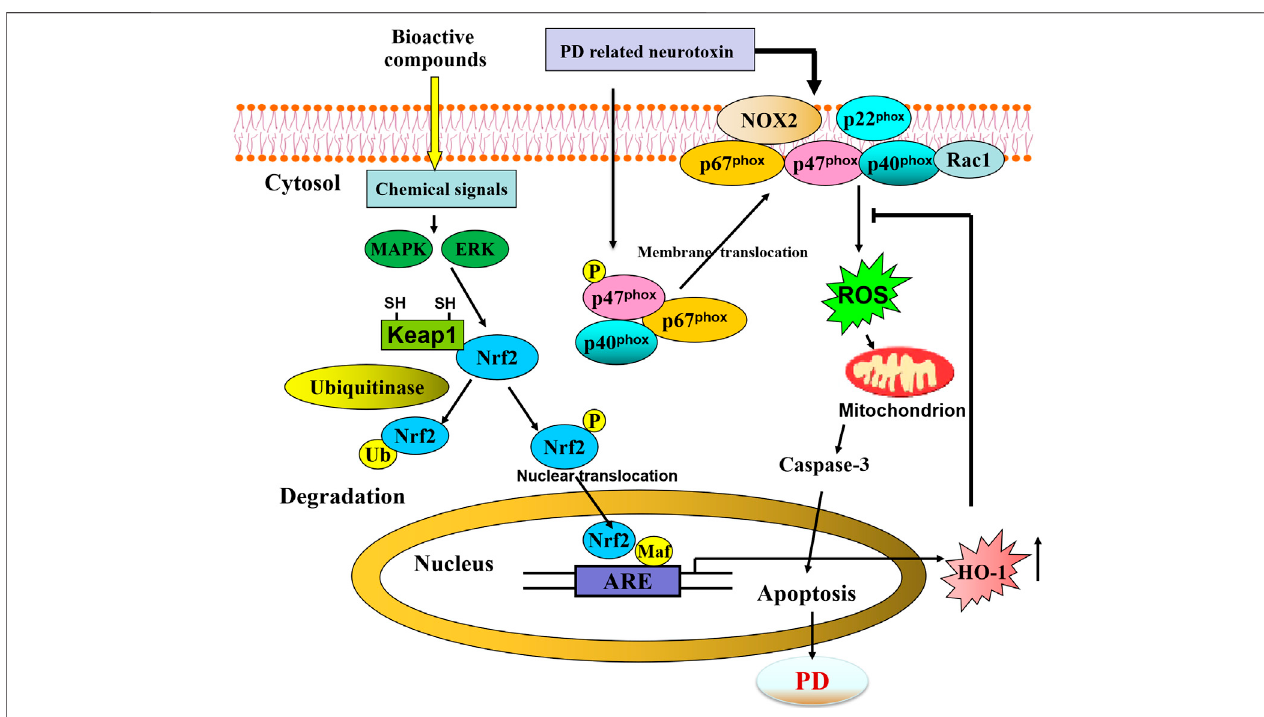
FIGURE 7 | Schematic representation of bioactive compounds-mediated neuroprotective against PD through activating Nrf2/ARE/HO-1 pathway.